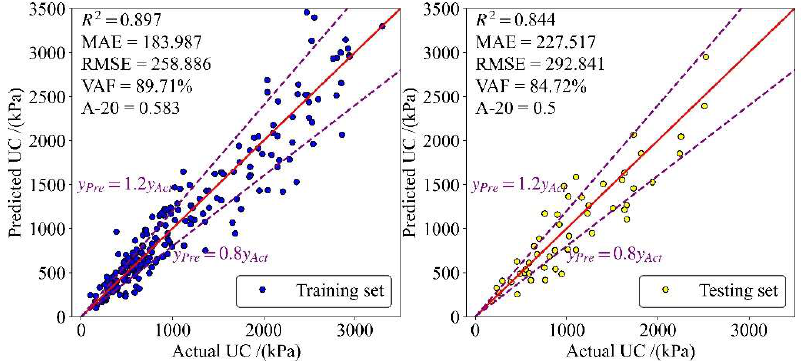
Figure 8. The performance of equation developed by GP in training and testing sets.